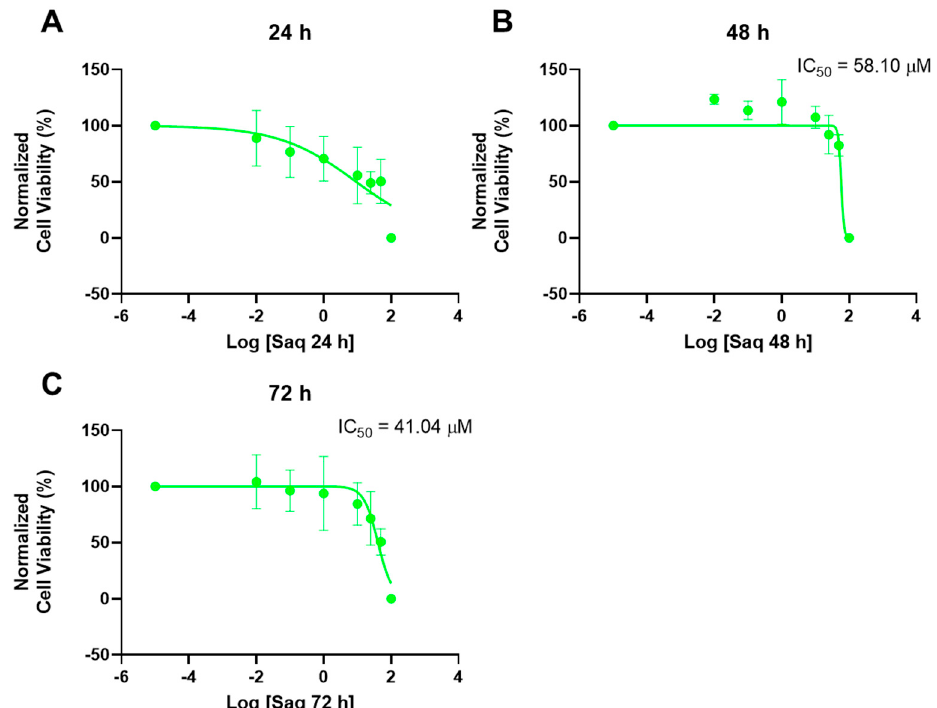
Figure 16. Dose-response curve and IC 50 of A549 after exposure to increasing concentrations of saquinavir (0.01 − 100 µ M) for 24 h ( A ), 48 h ( B ), and 72 h ( C ). Control cells were treated with 0.01% DMSO (vehicle). Cell viability was obtained using the MTT assay and the results were normalized and are given as the mean ± SEM ( n = 3).